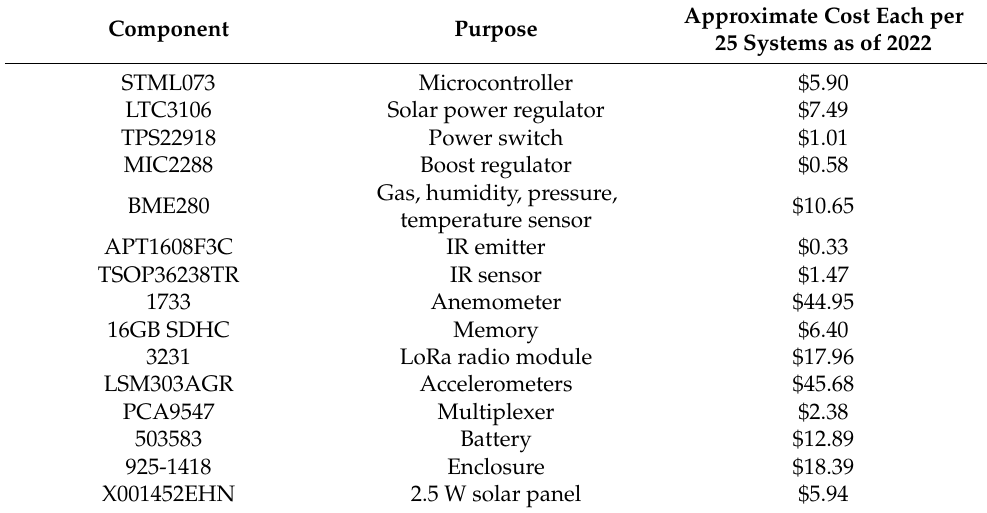
Table 3. Major components and their